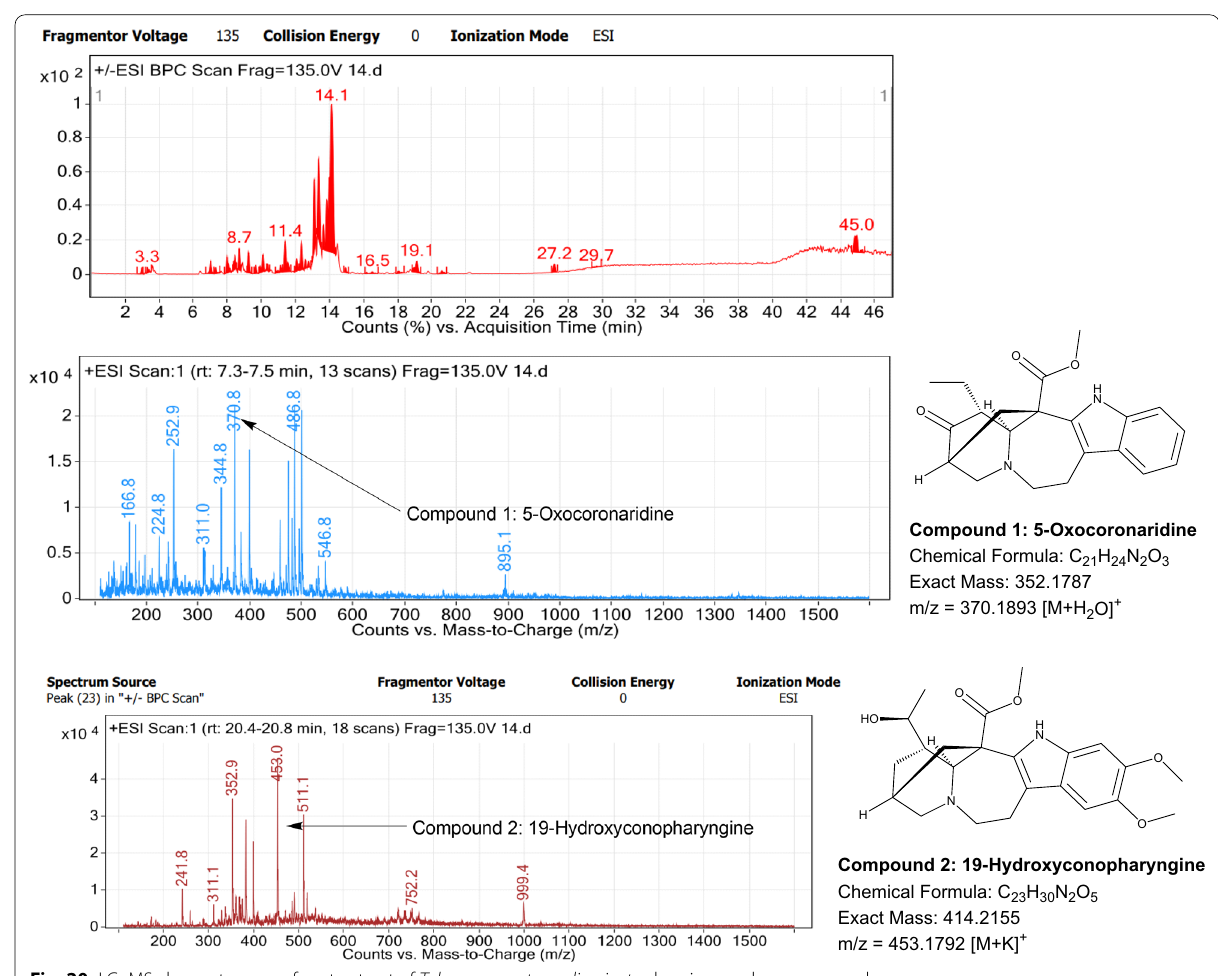
Fig. 20 LC–MS chromatogram of root extract of Tabernaemontana divaricata showing marker